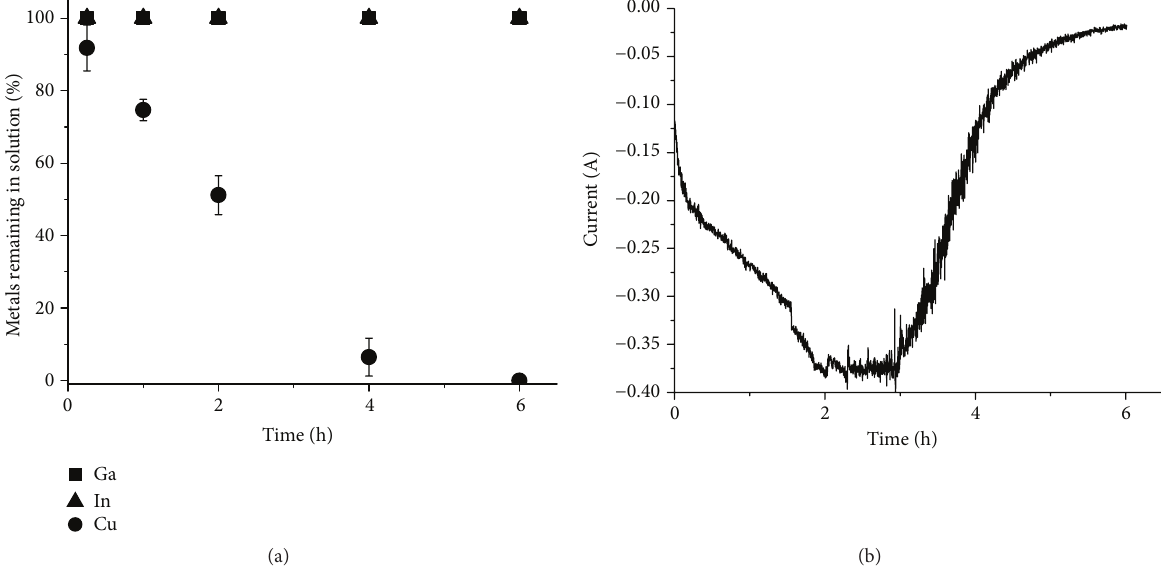
of H 2 O 2 at 80 ∘ C (Solution 2). (a) The metal concentration in the solution relative to the original concentration as a function of time. (b) The current passed though the circuit as a function of